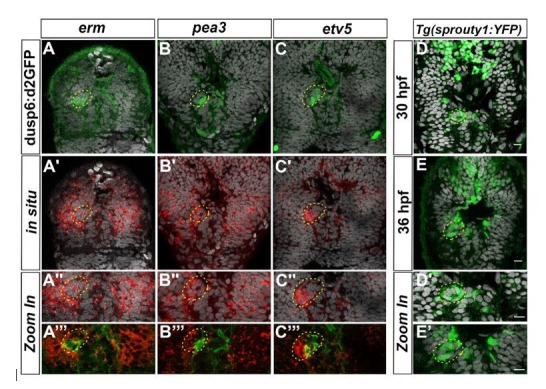
Expression of others FGF target genes in the epithalamus.Confocal sections of the head of Tg(dusp6:d2EGFP) embryos (A-C’’’) at 36 hpf after a whole-mount in situ hybridization against erm (red, A-A’’’), pea3 (red, B-B’’’), etv5a (red, C-C’’’) or of Tg(sprouty1:YFP) embryos at 30 hpf (D-D’) or 36 hpf (E, E’) after immunostaining against GFP (Green; A-E’); the pictures are merged with cell nuclei staining (Topro-3 in grey) that makes brain structures visible and specially the parapineal (yellow circle). A’’-C’’’, D’-E’ show Zoom in of merge pictures. Embryos are viewed dorsally with anterior up.